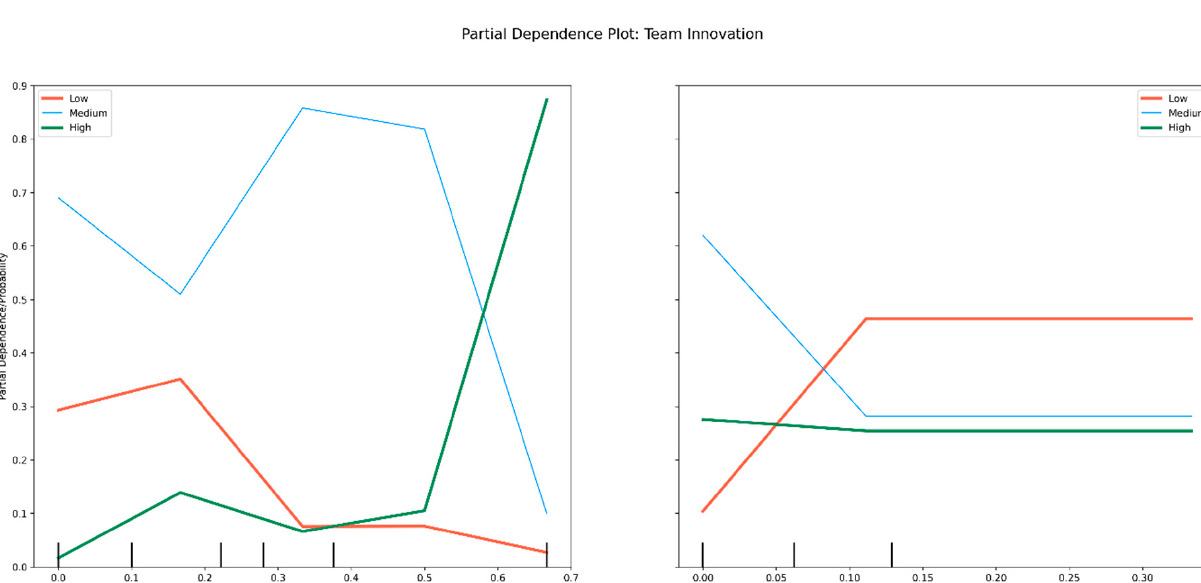
Figure A2. PDP of Team Innovation Model.